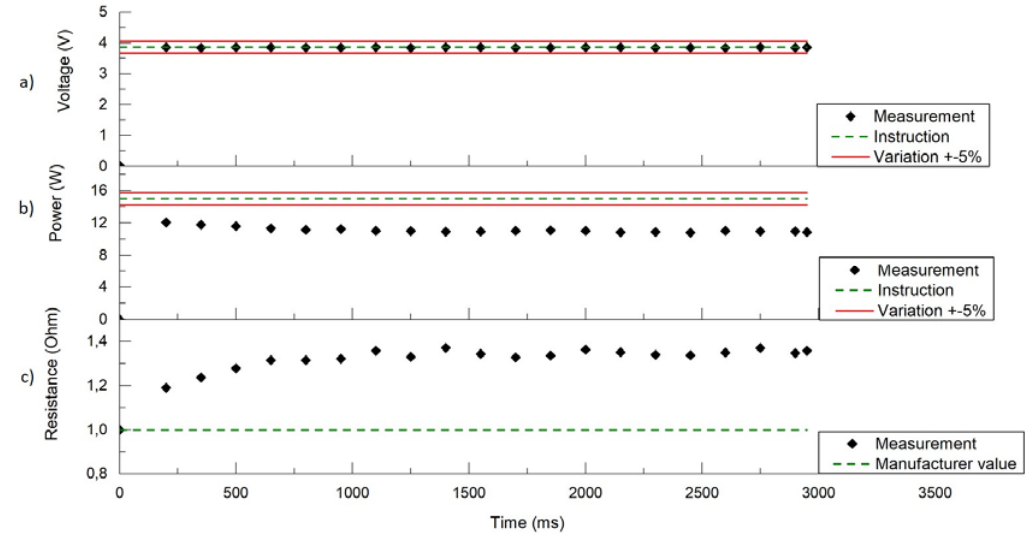
Figure 6. Voltage applied to the resistor ( a ), corresponding power applied ( b ) and resistor value ( c ) during a typical puff.